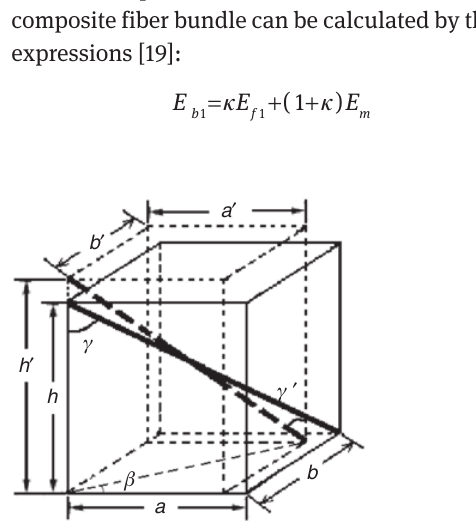
Figure 1: Schematic diagram of a unidirectional composite fiber bundle in an inner single